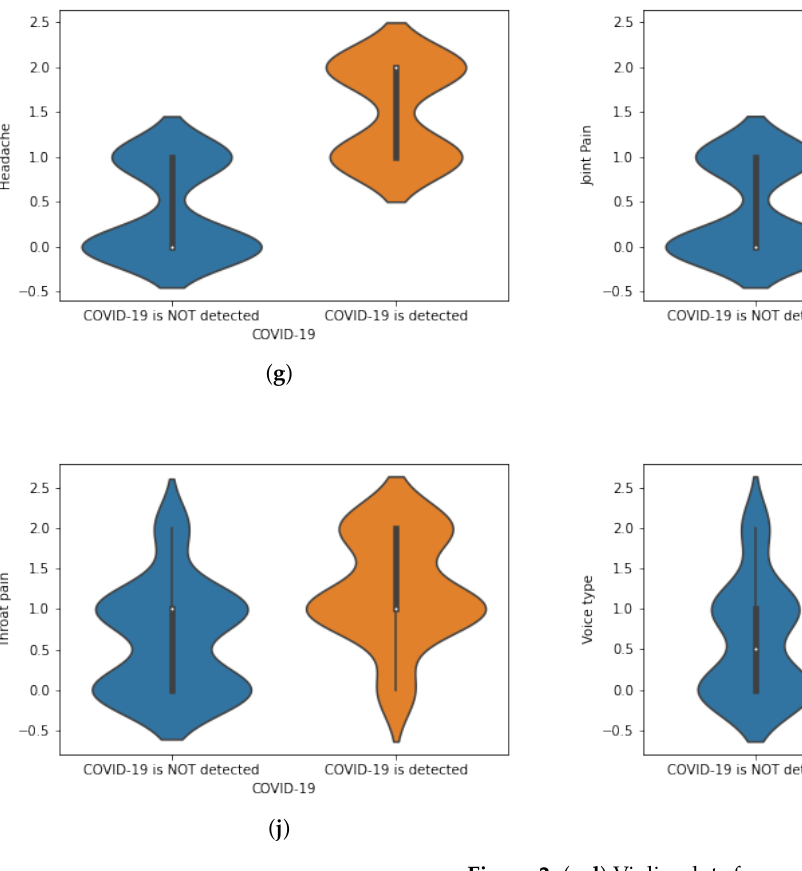
Figure 2. ( a – l ) Violin plots for corresponding to each feature used in the